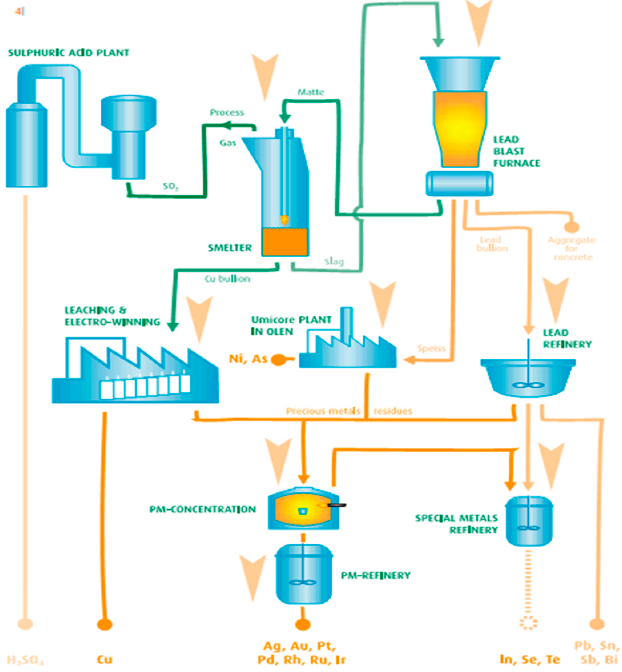
Figure 1. Umicore waste-to-metals technology [12].